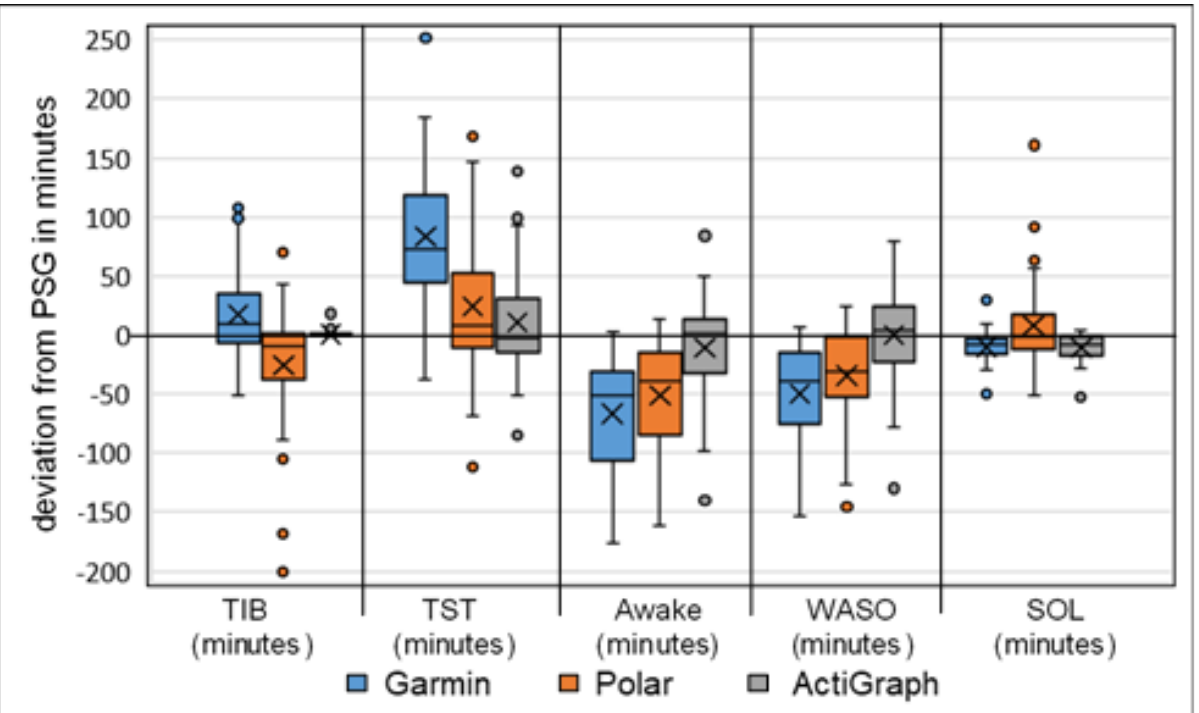
Figure 2. Boxplot analysis of calculated deviation in sleep parameters, Garmin, Polar and ActiGraph GT9X against the gold standard PSG ( n = 49), TIB = time in bed, TST = total sleep time, Awake = awake time (WASO + SOL), WASO = wake after sleep onset, SOL = sleep onset latency (all expressed in minutes); the x represents the mean value of deviation.